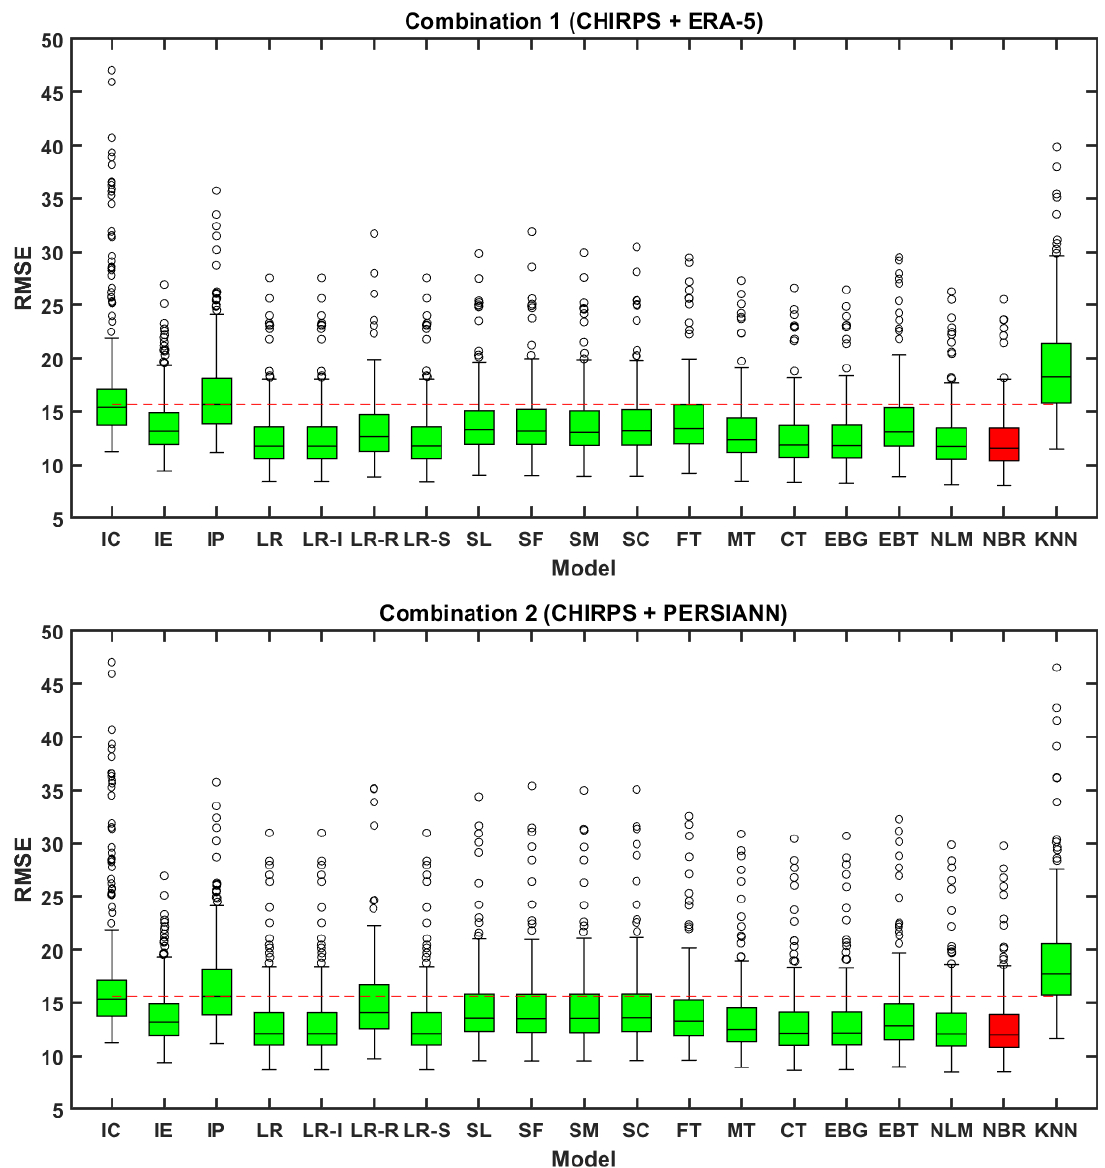
Figure 4. Boxplots representing the performance of individual and integrated precipitation dataset under four combinations in terms of R (IC represents IMD vs. CHIRPS, IE represents IMD vs. ERA-5, and IP represents IMD vs. PERSIANN CDR).